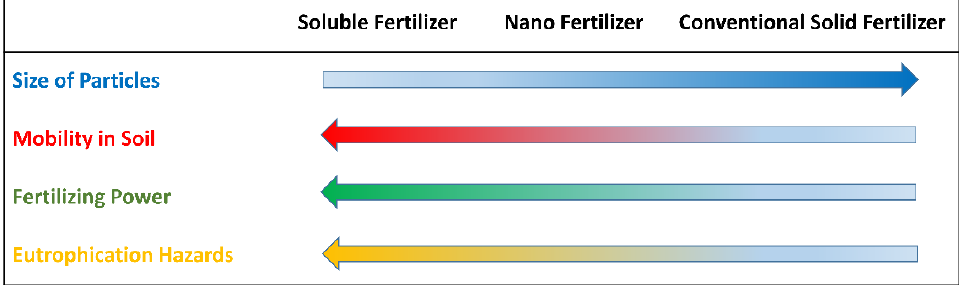
Figure 2. A schematic comparison of soluble P, nano-sized solid P and solid P fertilizers and their environmental properties. “Adapted with permission from Ref. [38]. 2014, Springer Nature”.